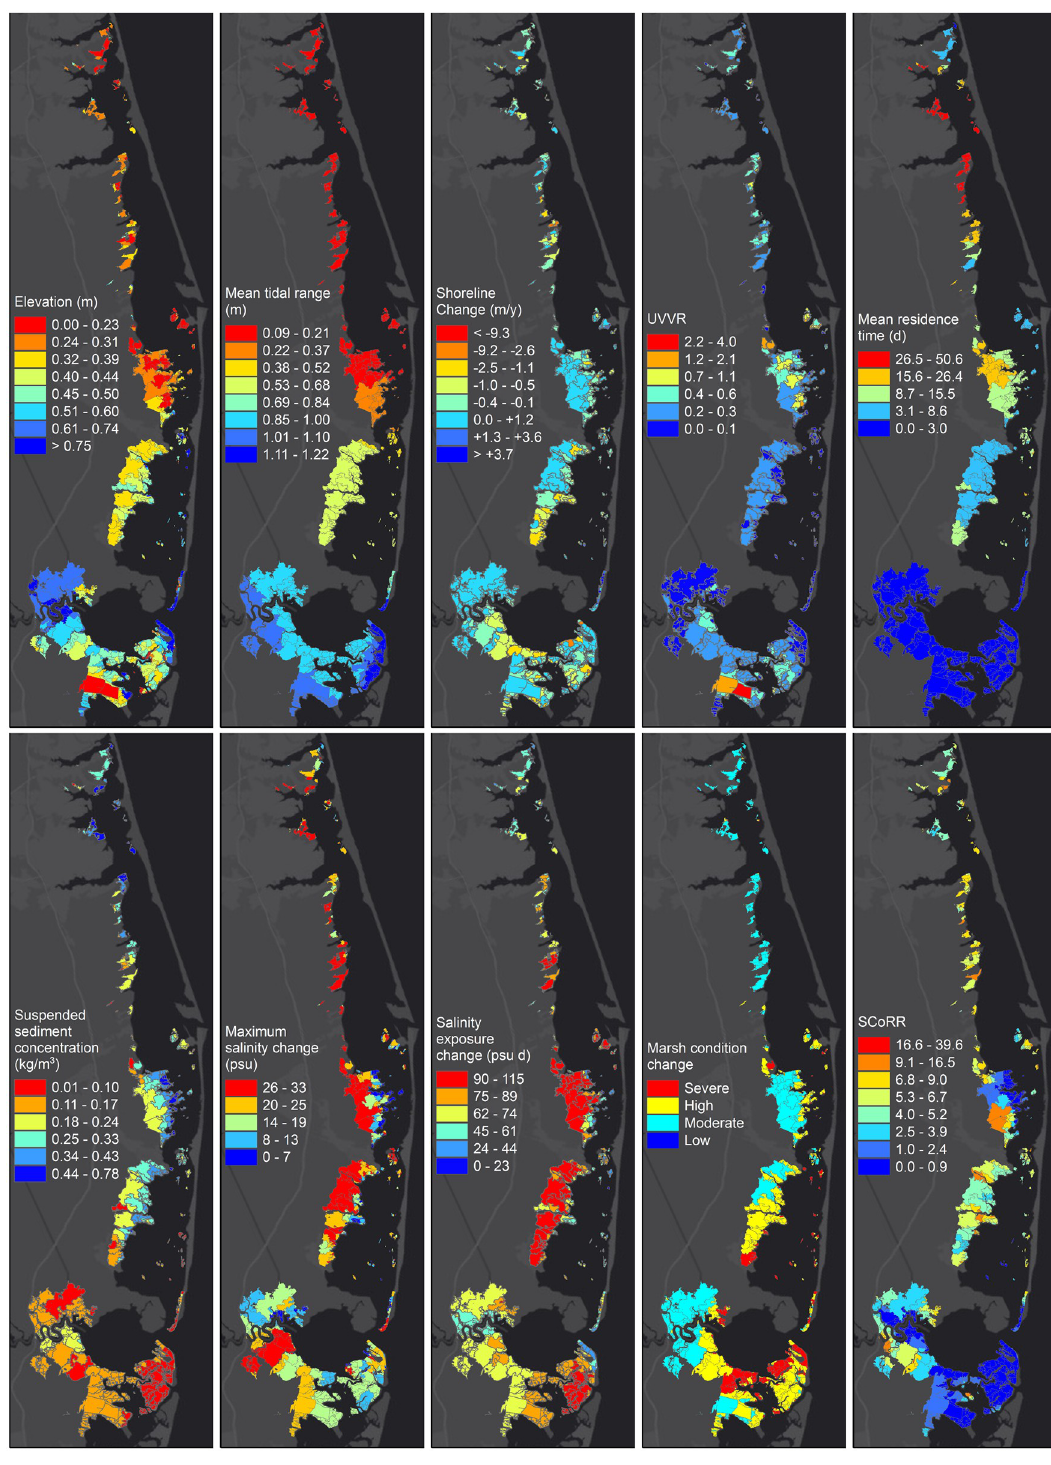
Fig 2. Wetland data layers. Underlying geospatial data has been averaged over the conceptual marsh units. Top row (from left to right): Elevation, mean tidal range, shoreline change, unvegetated to vegetated marsh ratio, and mean residence time. Bottom row: suspended sediment concentration, maximum salinity change, salinity exposure change, marsh condition change, and sediment- bound contaminant index.